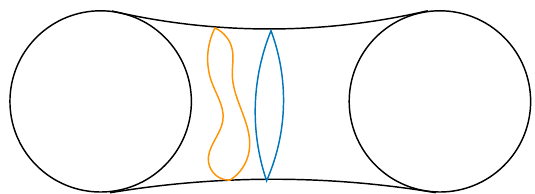
Figure 8 . Our antiloop l is shown in and orange and the minimal surface in blue. The antiloop give us boundary conditions which allow the minimization program to calculate the minimal